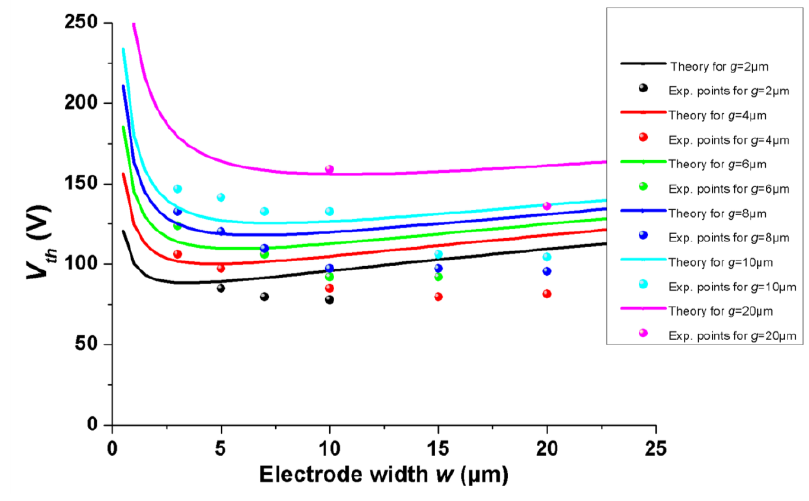
inter-electrode gap g . Solid line curves and circle labels represent the numerical results and experimental data respectively. The actuated liquid corresponds to DI water ( σ = 6 × 10 −5 S m −1 , ε = 80 ) and chip materials are described in Section liq liq